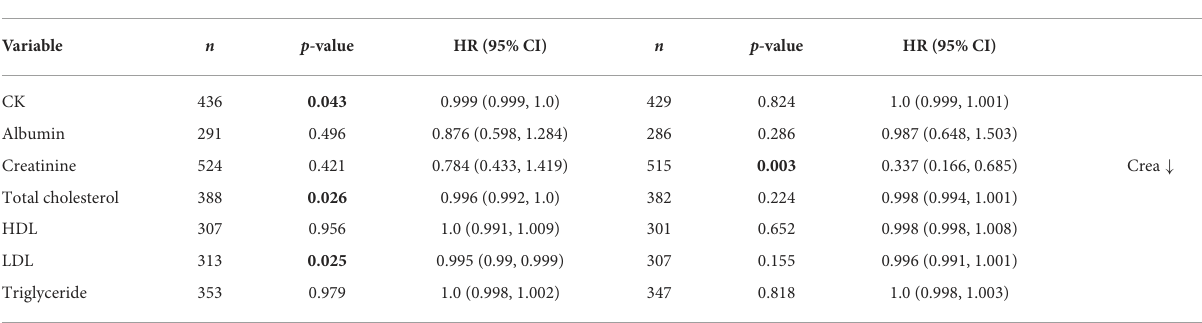
TABLE 6 Cox regression models for time from diagnosis until death/censorship. Univariate analysis Multivariate